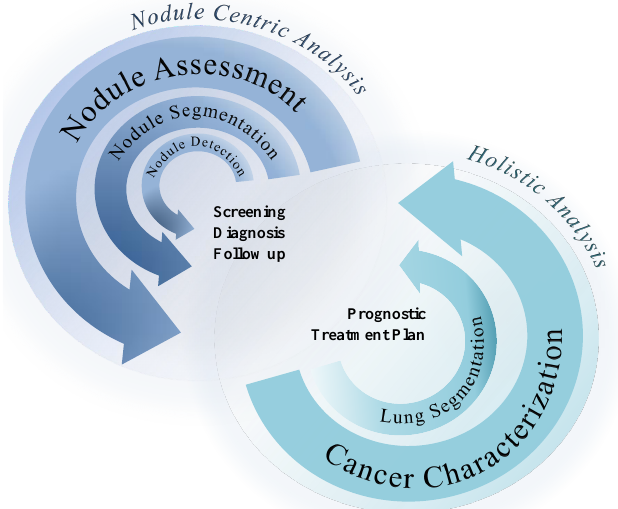
Figure 4. Two main perspectives for CADs in lung cancer, focused on the nodule and a more holistic approach that takes into consideration information about the surrounding structures of the